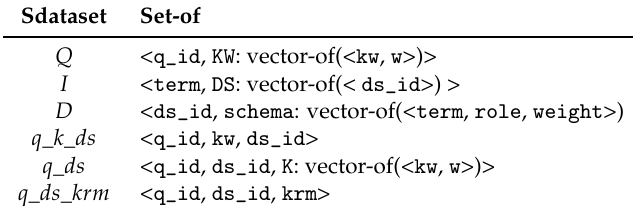
Table 1. Structure of Spark datasets in procedure Step4/5_Executor reported in Algorithm 5. Sdataset Set-of